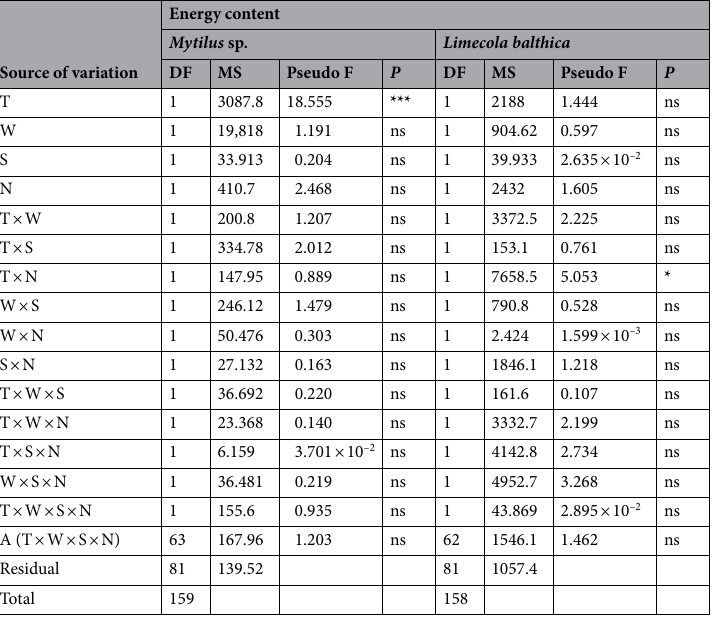
Table 4. Results of PERMANOVA analyses investigating the effect of exposure time (T), temperature (W), salinity variation (S) and nutrient enrichment (N) on energy content in the tissues of Mytilus sp. and L. balthica (kJ g −1 of dry mass). The factors temperature (W), salinity variation (S), nutrient enrichment (N) were set as fixed, and aquarium (A) as random. Details are provided for degree of freedom (DF), mean square (MS), Pseudo F and probability level ( P